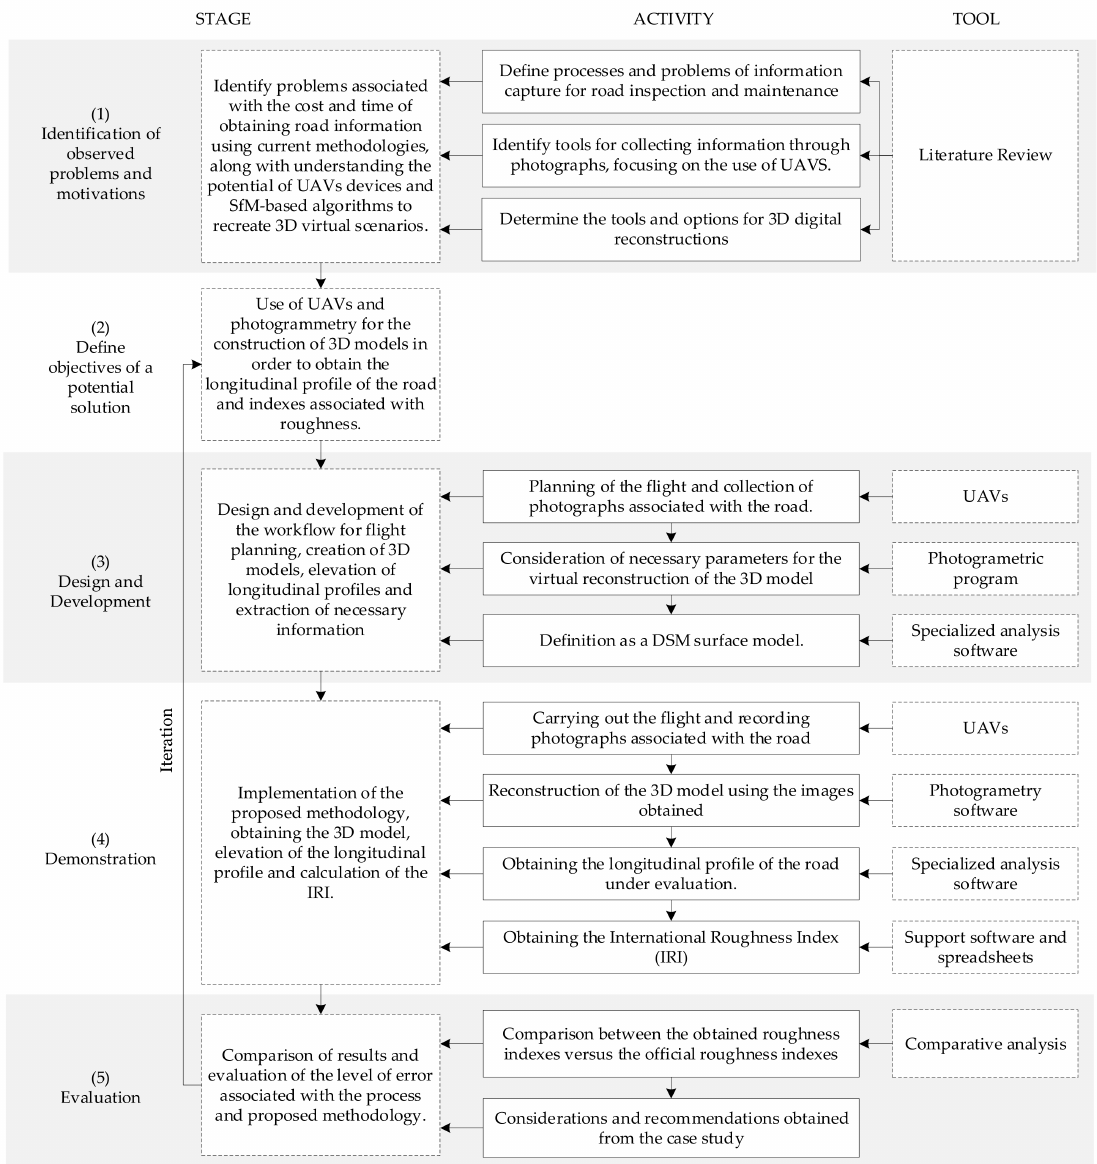
Figure 1. Research